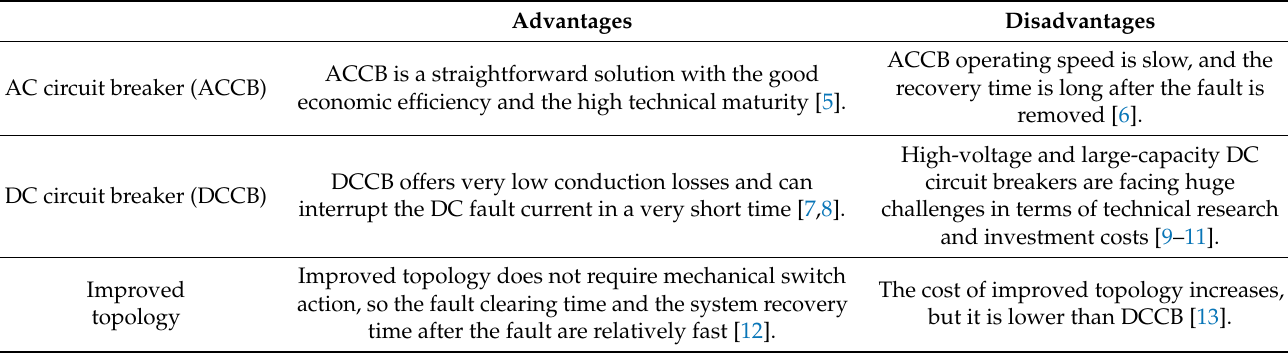
Table 1. Comparison of methods to deal with a short circuit fault of a DC side line.